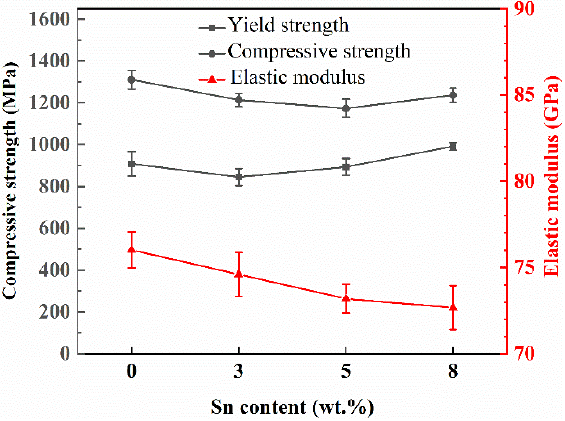
Figure 5. Compressive strengths and elastic modulus of PM-fabricated Ti-10Nb-xSn alloys.